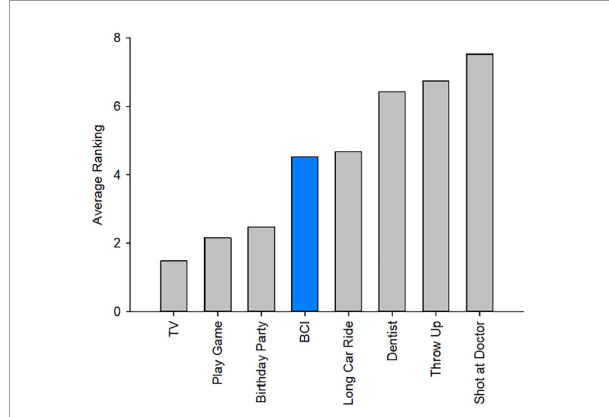
FIGURE5 Brain computer interface ranking among other childhood experiences: Average ranking comparing the experience of BCI-FES to common childhood activities. Ranking listed from most to least enjoyable